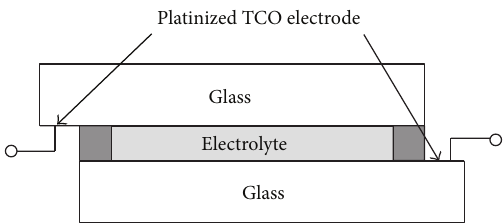
Figure 1: Schematic diagram of the experimental thin-layer cell configuration employed for the electrochemical measurements.